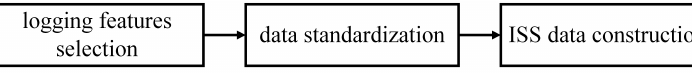
Figure 3. Flowchart of the ISS dataset construction.